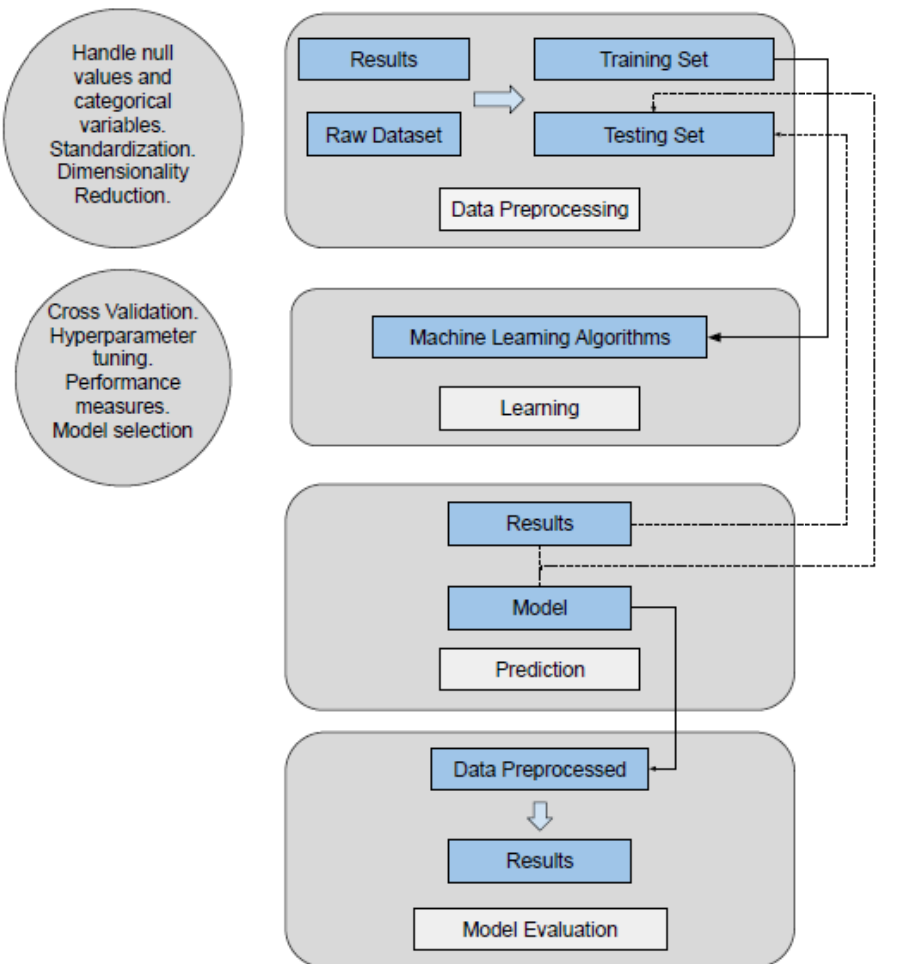
Figure 1. Roadmap for applying Machine Learning algorithms in predictive analysis (Raschka and Mirjalili,